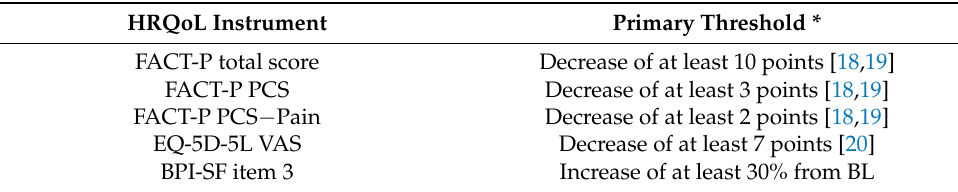
Table 2. Thresholds for meaningful